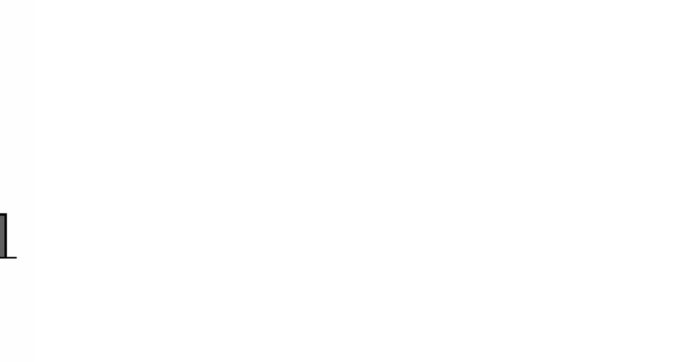
Figure 1. Percentage of invariant natural killer T (iNKT) cells in T lymphocytes from peripheral blood mononuclear cells from healthy controls, non-alcoholic fatty liver disease (NAFLD) and drug-induced liver injury (DILI) patients. Data are presented as mean ± standard error of the mean. * p ≤ 0.05.